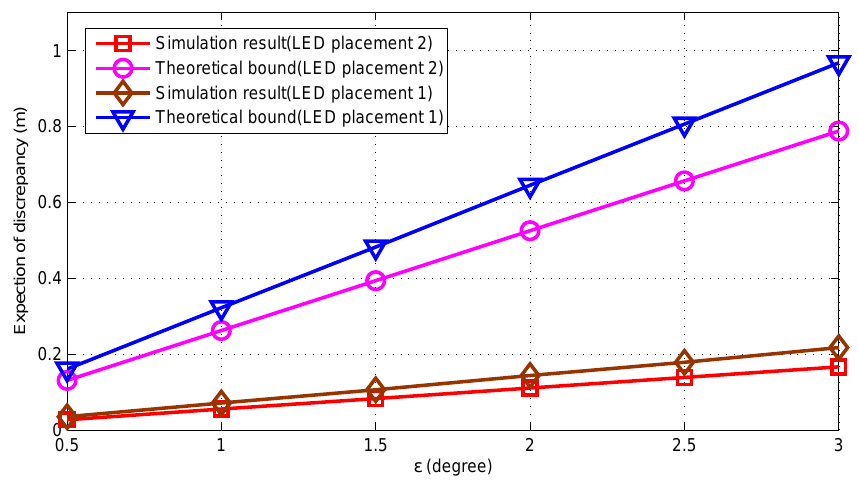
Figure 6. Performance analysis versus different LED